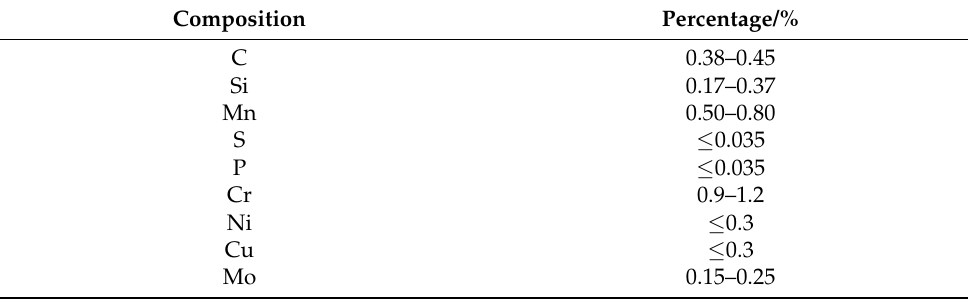
Table 1. The chemical component of the material 42CrMo.